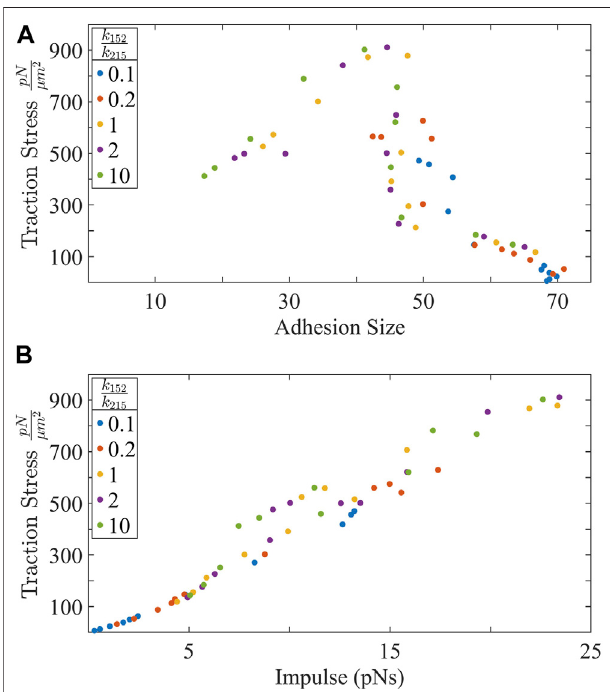
FIGURE5|(A) Tractionstressisbiphasicwithadhesionsize.Thereisan initial increase in traction stress with adhesion growth, followed by a regime where traction stress is decouple from the adhesion size. Interestingly, largest adhesion sizes correspond to lowest traction forces generated. (B) Traction force increases almost linearly with the impulse transmitted by individual actin-myosin fi laments to the substrate.